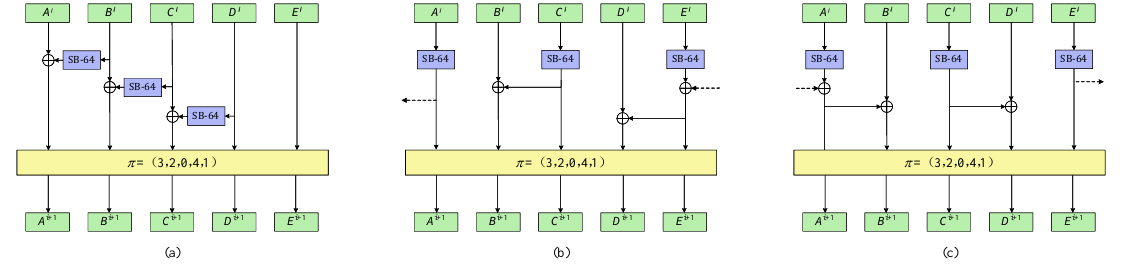
Figure 5. Three new ways of XOR. ( a ) structure; ( b ) structure; ( c ) structure.